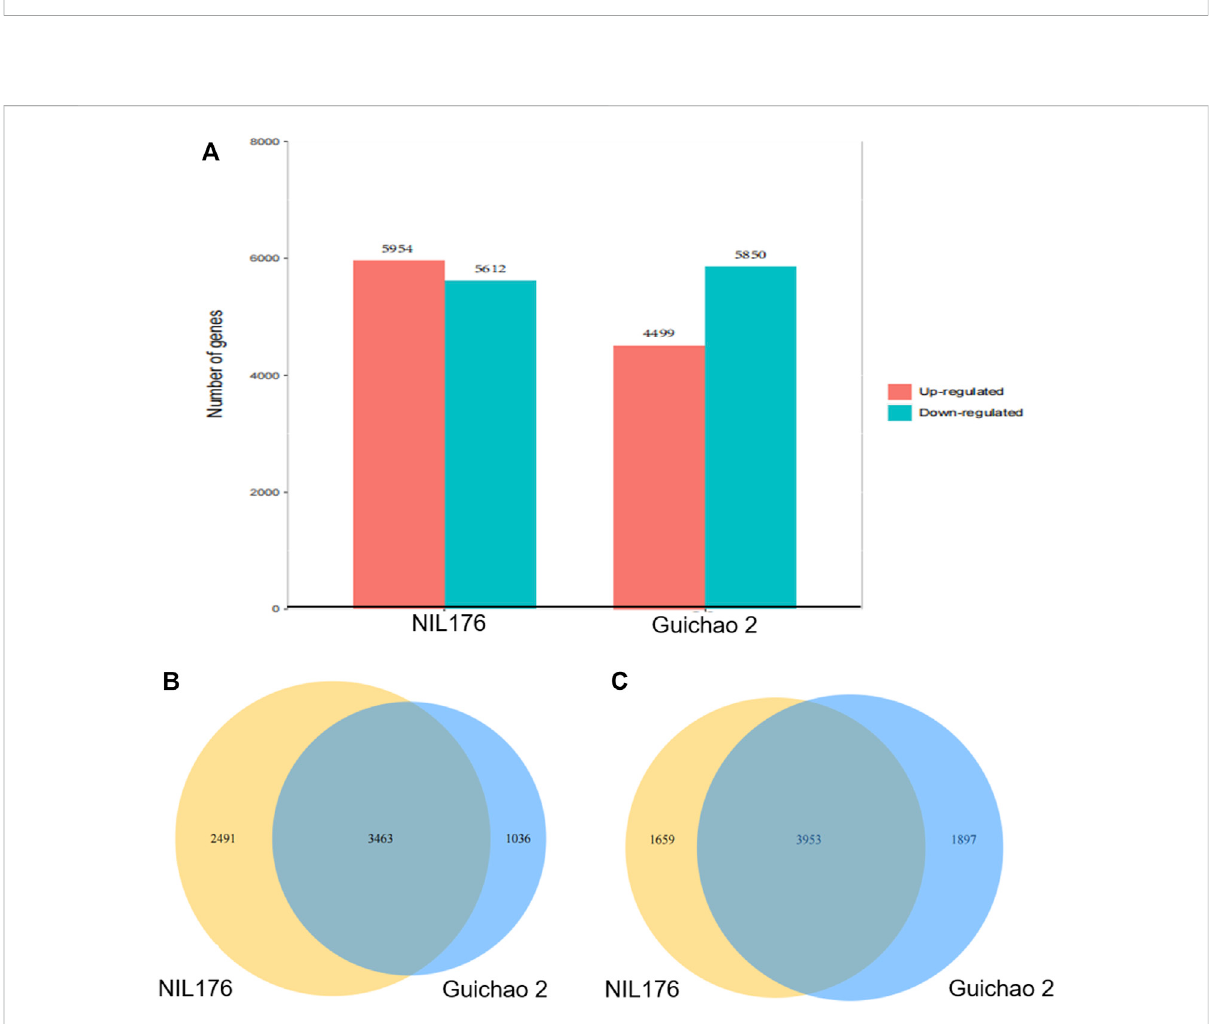
FIGURE 4 Comparisonsofdifferentiallyexpressedgenesbetween NIL176andGuichao2undercold stress. (A) :Numbers ofdifferentiallyexpressed genes in NIL176 and Guichao 2. (B) : Up-regulated differentially expressed genes in NIL176 and Guichao 2. (C) : Down-regulated differentially expressed genes in NIL176 and Guichao